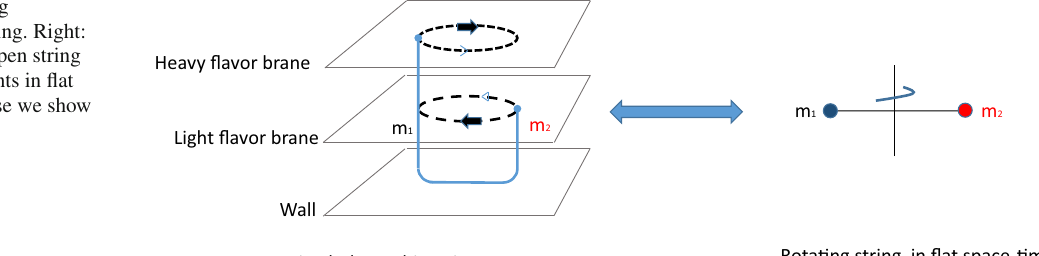
Fig. 1 Left: Rotating holographic open string. Right: The corresponding open string with massive endpoints in flat spacetime. In this case we show a heavy–light meson m 1